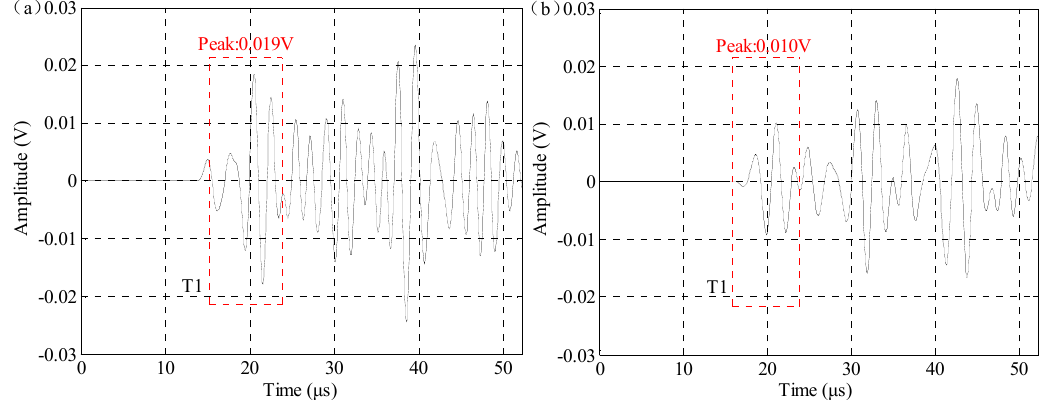
Figure 9. A-wave signal obtained from the computational simulation of the intact model and the embedded defect model. ( a ) corresponds to the intact model, and ( b ) corresponds to the embedded defect model.